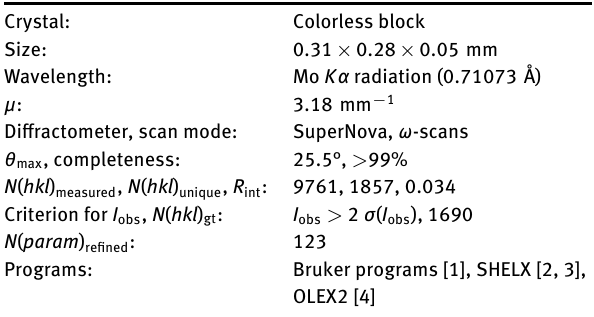
Table 1: Data collection and handling.